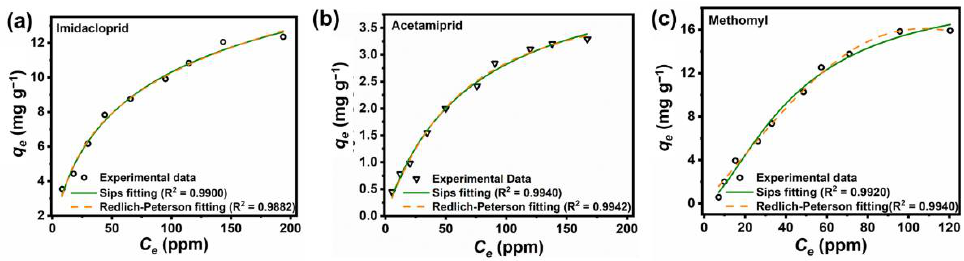
Figure 4. Three-parameter adsorption isotherms of ( a ) imidacloprid, ( b ) acetamiprid and ( c ) methomyl on the BC, respectively, by the Sips and Redlich–Peterson models. Conditions: 100 mL of aqueous solution of pesticide, pH = 7, 25 ◦ C, 6 h.